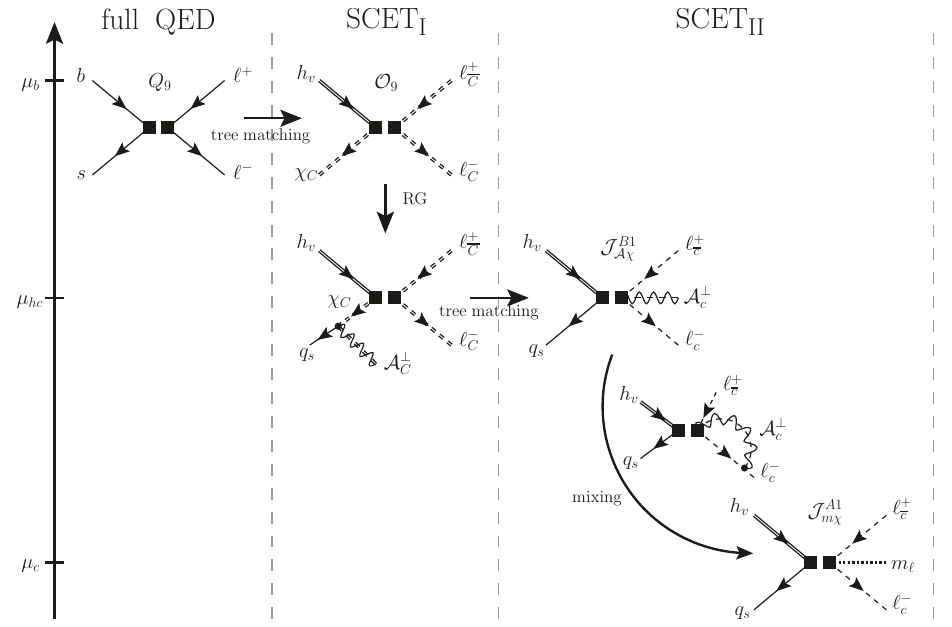
Figure 3. The scheme shows the tree-level matching steps from full QED at the two scales (cid:22) b and (cid:22) hc horizontally from left to right. Vertically the RG evolution in SCET I involves only self-mixing, whereas in SCET II a mixing takes place of the operators The notation and scaling of the SCET (cid:12)elds are given in table 1. The propagators of the (cid:12)elds are chosen as double-solid for the heavy quark h v , double-dashed for hard-collinear fermions in SCET I , whereas single-dashed for collinear fermions in SCET II . The double- and single-dashed lines accompanied by a wavy line depict the hard-collinear and collinear photon (cid:12)elds in SCET I and SCET II , respectively. The single-solid line depicts the soft spectator quark q s . The dotted line A 1 in indicates that this operator contains a factor of the lepton mass m ‘ . m(cid:31) J To reproduce the C e(cid:11) term in (1.1), the matching to the (cid:12)rst of these operators is 9